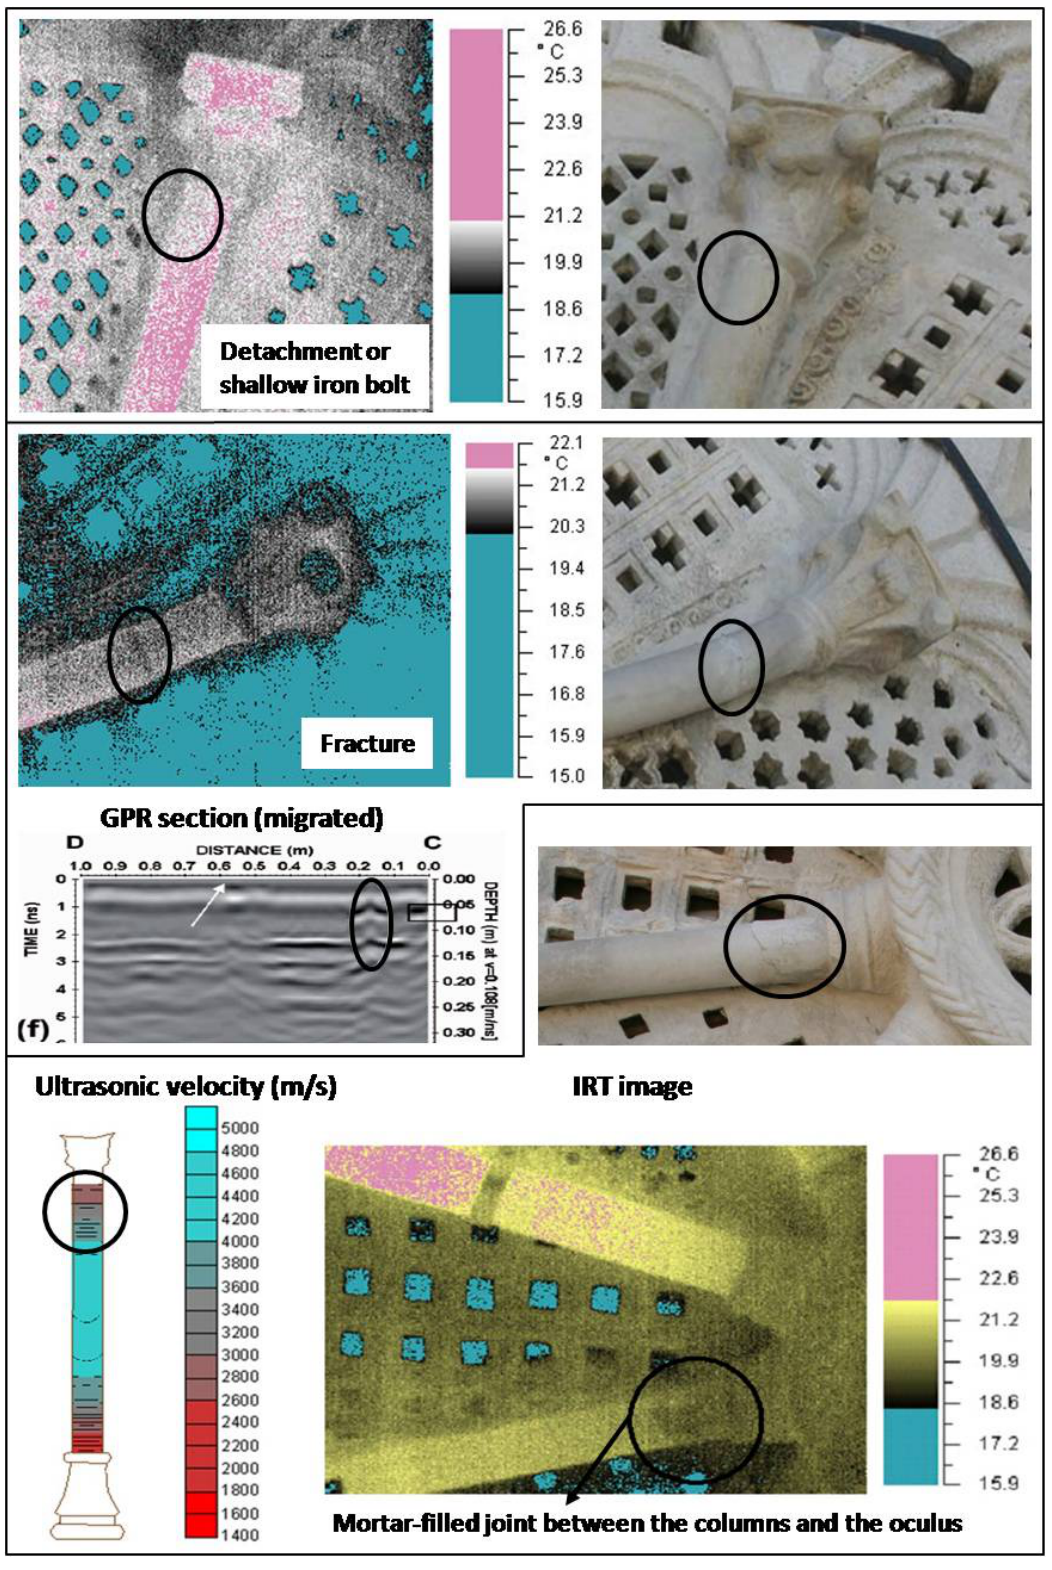
Fig. 5. Examples of IRT images and comparison with high-resolution photographs, 1500MHzGPR investigations (middle) and ultrasonic tests